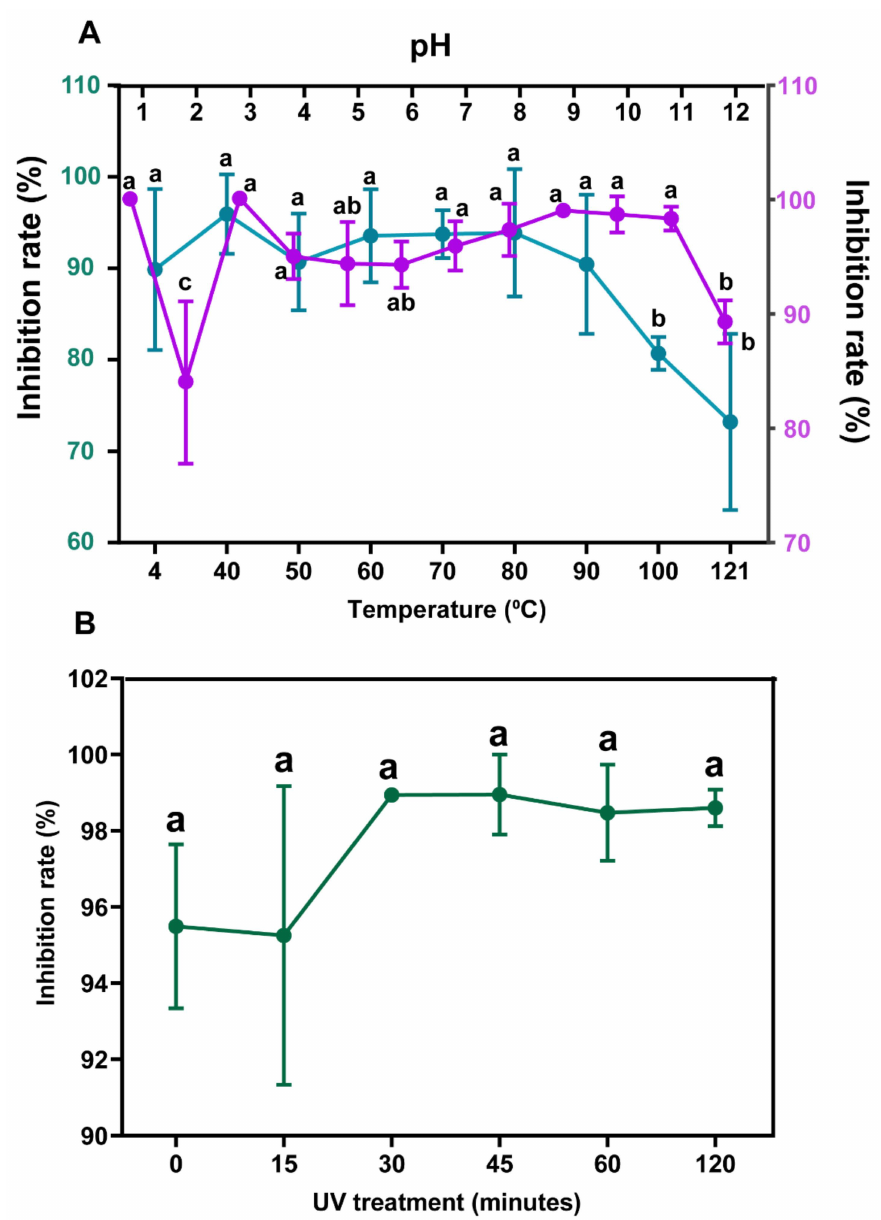
Figure 7. ( A ) Stability of Bacillus subtilis L1-21 in the presence of different temperatures and pH treatments. ( B ) UV effect on B. subtilis L1-21. Different letters on top indicate the significant differences ( p < 0.05) over increasing temperature, pH and